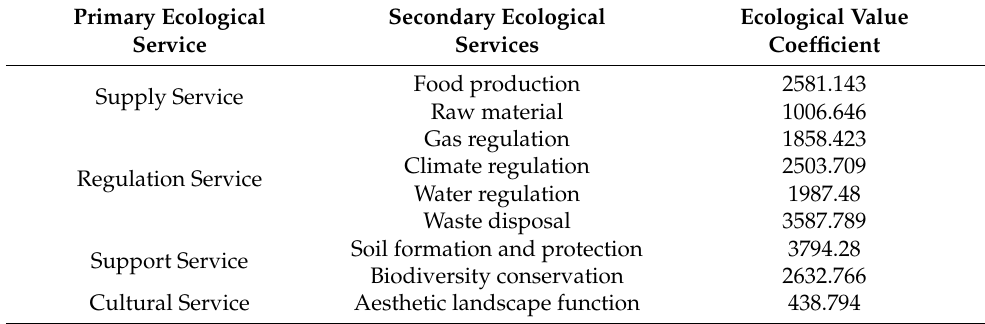
Table 1. Equivalent table of farmland ecosystem service value per unit area (yuan · hm 2 · a − 1 ). Primary